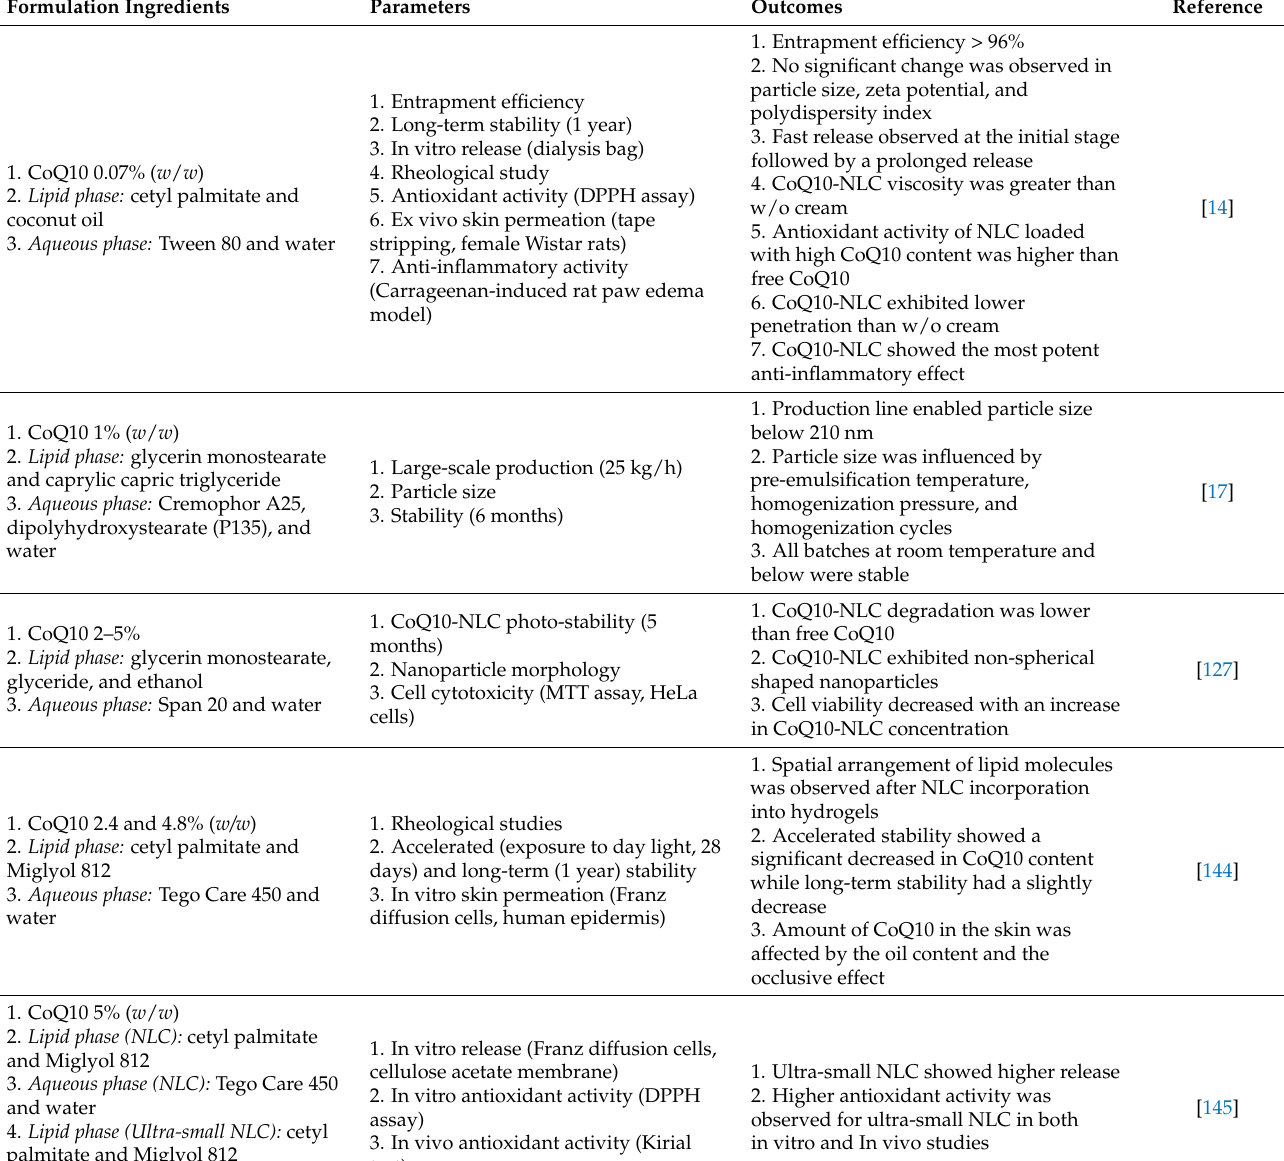
Table 6. Studies on CoQ10 encapsulation in nanostructured lipid carriers (NLC) employing high-pressure